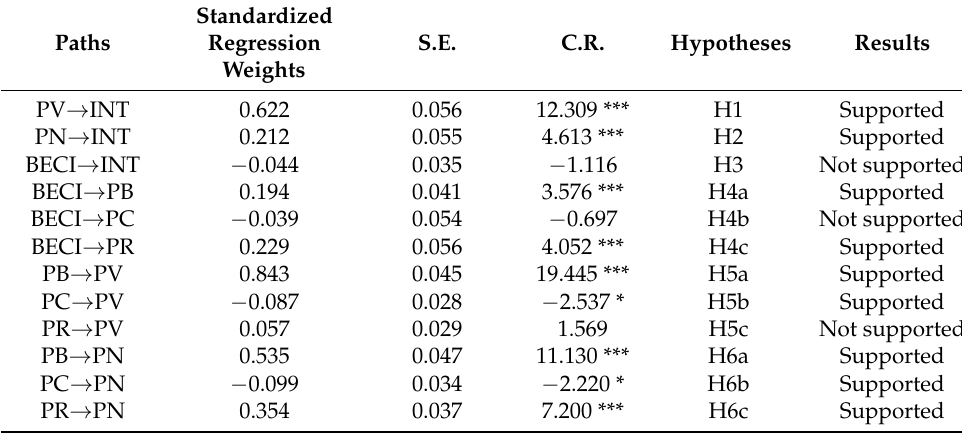
Table 4. Path coefficient estimation of the